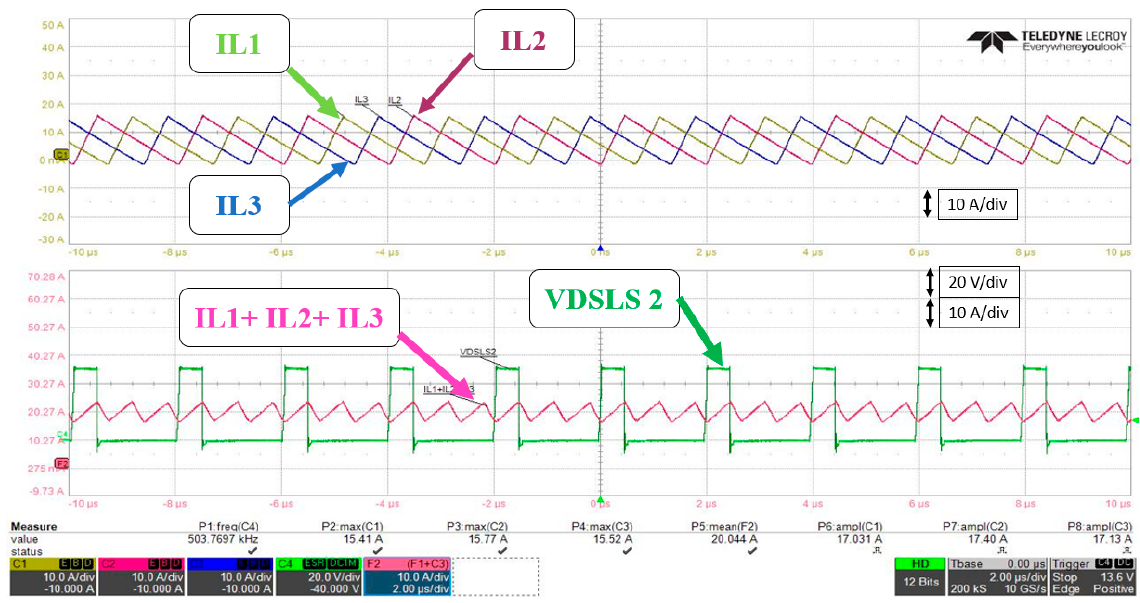
Figure 12. Phase current waveforms for each leg and total output current waveform at 20 A load condition.